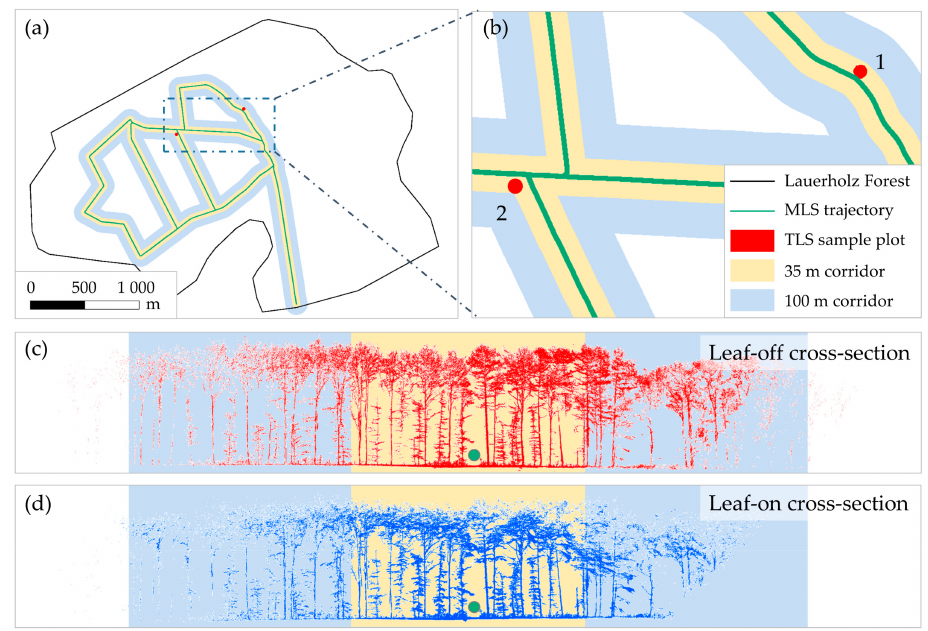
Figure 2. ( a , b ) Study area with the MLS trajectory (green line) and the two sample plots (red circles). ( c ) Vertical slice through MLS point cloud under leaf-off or ( d ) leaf-on conditions with a 35 m (yellow) and 100 m (blue) corridor from the